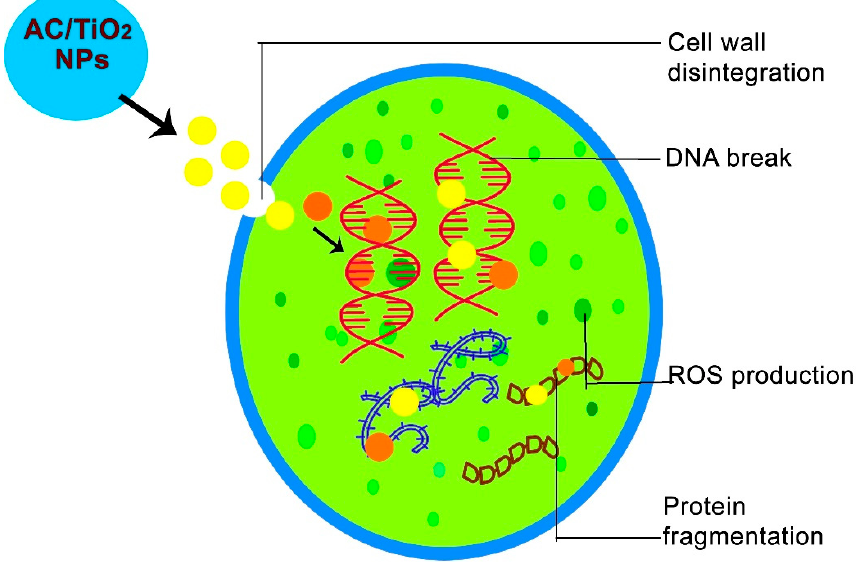
Figure 8. Zone of inhibitions of AC and plant extract against various pathogens.